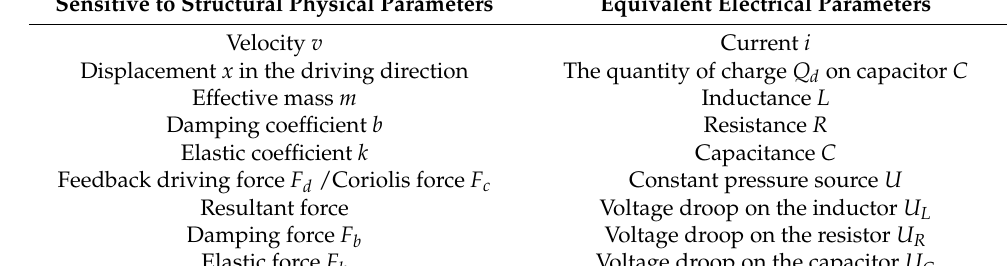
C d Figure 3. Equivalent electrical model of MEMS gyroscope. The simultaneous Equations (18) and (20) can realize the transformation of the MEMS gyroscope’s mechanically sensitive structural mechanics model from mechanical domain to electrical domain, and the corresponding relationship is written in Table 1. According to the equivalent electrical model of the driving and sense direction of the MEMS gyro-